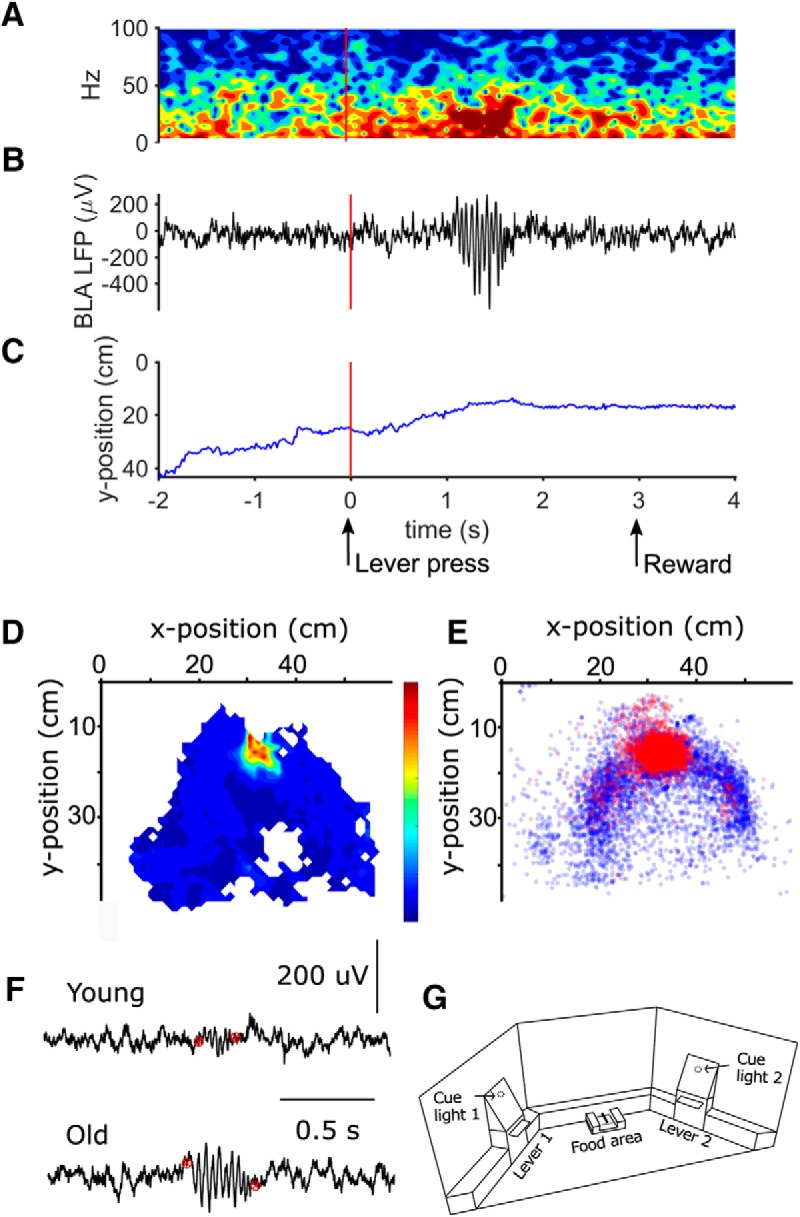
β Epochs occur primarily when old rats arrive at the reward zone. A, Example of a single trial spectrogram after a lever press. The vertical red line at 0 indicates lever press. Hot colors indicate elevated power. Vertical red lines denote the lever press (A–C). B, LFP trace corresponding to the spectrogram in A, showing a burst of β activity. C, y-position of the rat at the time of the LFP recordings in A, B. The blue line represents the position along the y-axis, as the rat goes toward the feeder (see y-axis depiction in E). The arrow at 0 s indicates lever press, and the one at 3 s indicates reward onset. D, Example of a session from an old rat. Shown is the average normalized heat map of β power weighted by the percentage time spent in that location. The color bar represents the gradient change in normalized power, warmer colors indicate the location with highest β power, and a lack of color indicates positions that were not covered by the rat during the session. The heat map in this panel is oriented similarly to the operant chamber illustration in G. E, Spatial location of β events of all aged rats (all sessions). The location was determined based on the position of the rat’s head at the start of each β oscillation, as shown in F. Red circles indicate β oscillations occurring between lever press and reward time points, whereas blue circles indicate all other β oscillations that occurred during the experimental tasks. F, LFP traces showing representative example bursts of β activity in young and old rats. The red markers indicate the start and end time points of each β burst. These time points were used to identify trials containing task-evoked β oscillations. Note that when present, β oscillations in young rats were of lower amplitude than those from the aged rats. G, Schematic drawing of the operant chamber used for the discrimination learning and decision-making task. The chamber is of trapezoid shape with small walls on the side of the chamber to minimize potential collisions between the brain implant and the chamber walls.